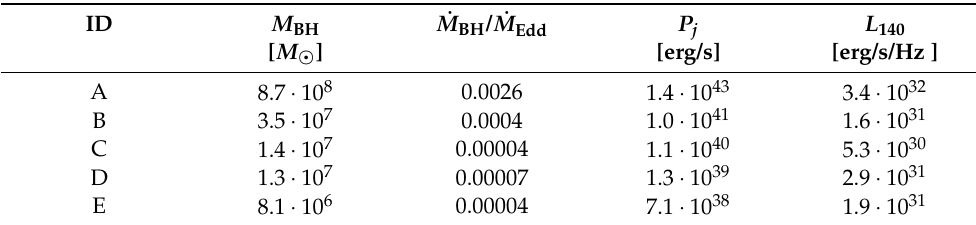
Table 1. Main parameters of SMBH and jet/radio power associated with the jets they emit (in which case the power is the sum of the power in the two